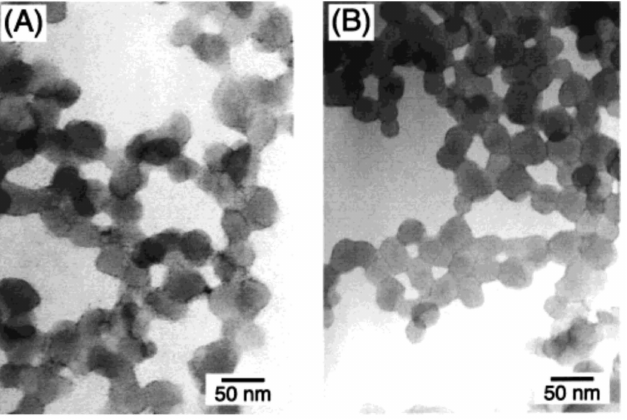
Figure 5. TEM image showing the C60 clusters ( A ) and C70 clusters ( B ) in an aggregated state